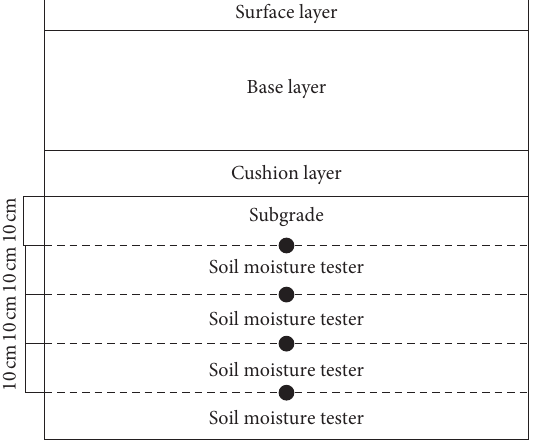
Figure 7: Schematic diagram of moisture analyzer layout.